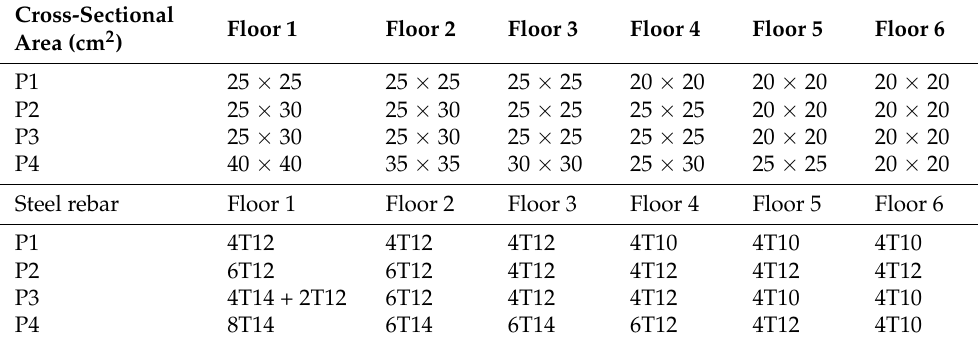
Table 6. Cross-sectional area of columns and adopted steel rebar for buildings without seismic code [39].